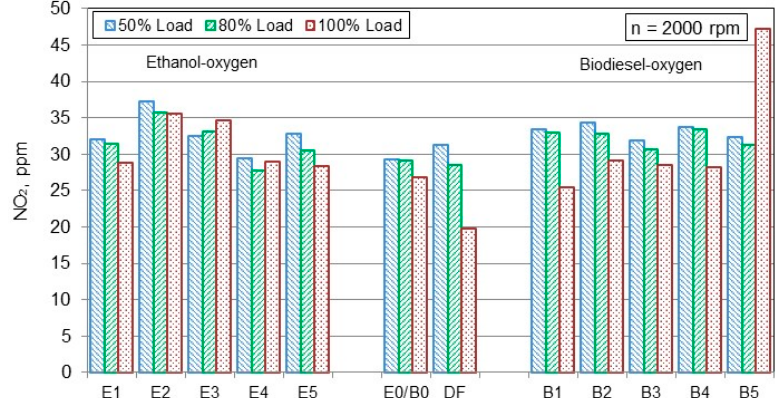
Figure 13. The changing trends in nitrogen dioxide (NO 2 ) emissions as a function of ethanol–oxygen or biodiesel-oxygen mass content (wt%) in fuel blends for medium (50%), intermediate (80%), and full (100%) loads corresponding to the respective IMEPs of 0.75, 1.20, and 1.50 MPa, developed at maximum torque speed of 2000